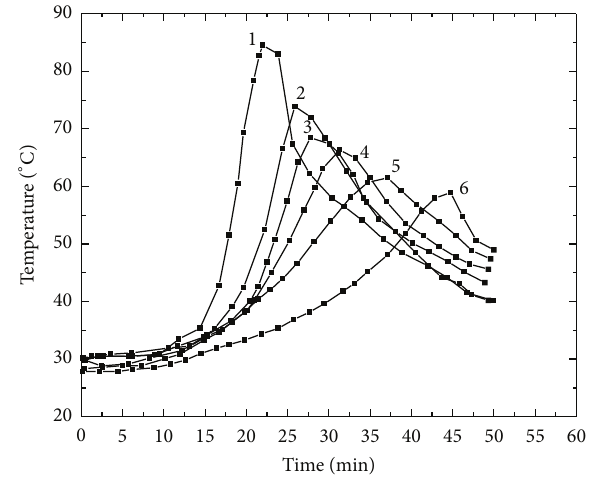
Figure 3: Temperature-time curves for zinc corrosion in 1.0M HCl